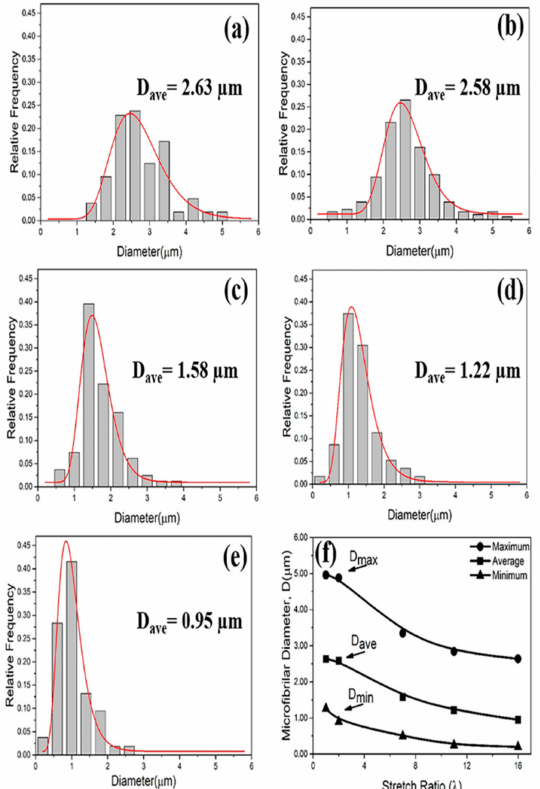
Figure 2. ( a – e ) The diameter distribution of the PA6 domains in the PP / PA6 blends with the stretch ratio of 1, 2, 7, 11 and 16. The average diameters ( D ave ) are marked. ( f ) The maximum diameter ( D max ), average diameter ( D ave ) and minimum diameter ( D min ) of the PA6 domains as functions of the stretch ratio of the PP / PA6